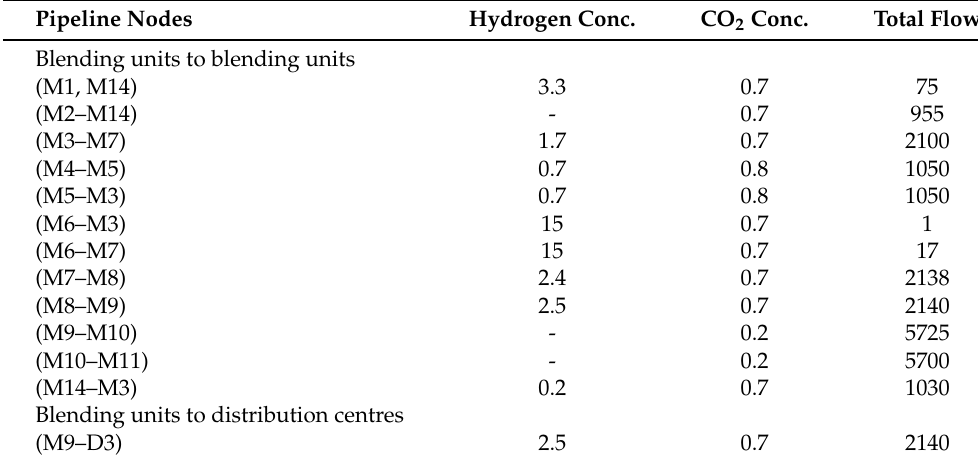
Table 3. Hydrogen and CO 2 concentration (in vol